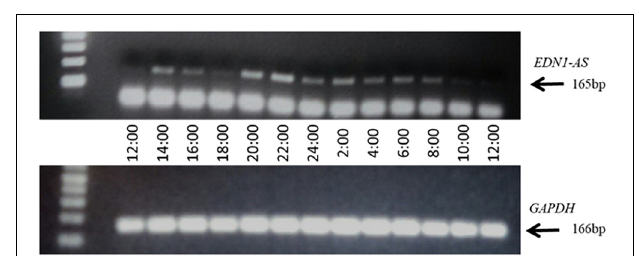
FIGURE 5 | EDN1-AS Exhibits a Circadian Rhythm of Expression. HK2 cells were treated with 100 nM dexamethasone for 30 min, after which media was replaced and cells incubated for 24 h. After 24 h (noon), RNA was isolated every 2 h for 24 h total. This RNA was used in strand-specific RT PCR reactions with either SS2 primer (to measure EDN1-AS ) or random hexamer reactions (to measure GAPDH ). For the PCR reactions, PCR1 and PCR2 primers were used in EDN1-AS reactions and GAPDH Fwd and GAPDH Rev primers were used in the GAPDH reactions. Gel representative of n = 3 independent experiments.